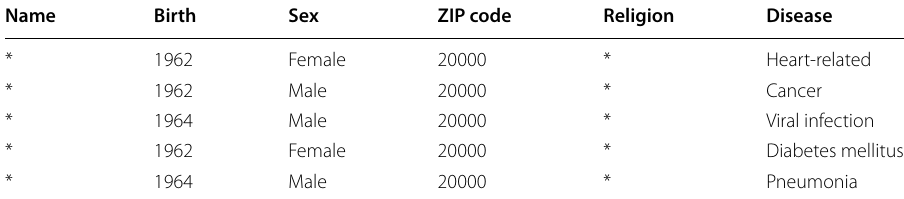
Table 4 2-anonymity with respect to the attributes ‘Birth’, ‘Sex’ and ‘ZIP code’